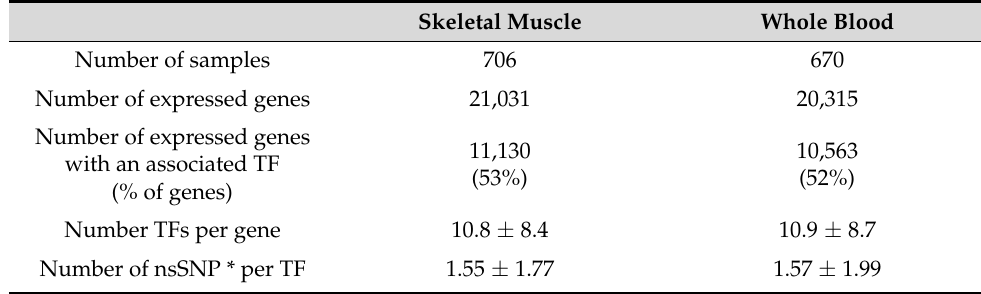
Table 1. Summary statistics of input data per tissue: transcription factors and associated SNPs.